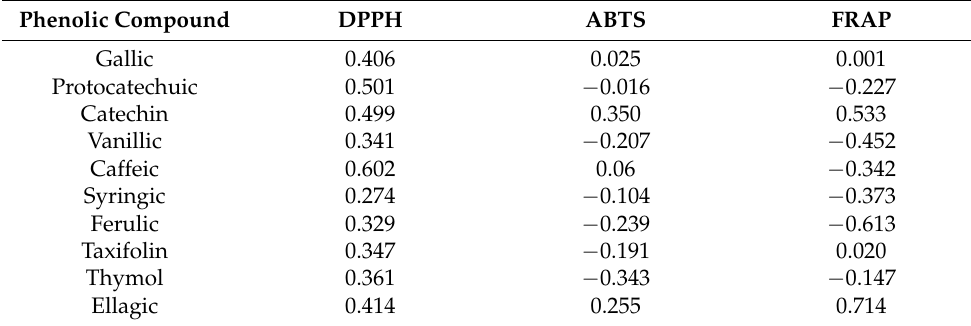
Table 7. Pearson correlation coefficient for individual phenolic compounds and DPPH, ABTS and FRAP activity of the pecan nut shell